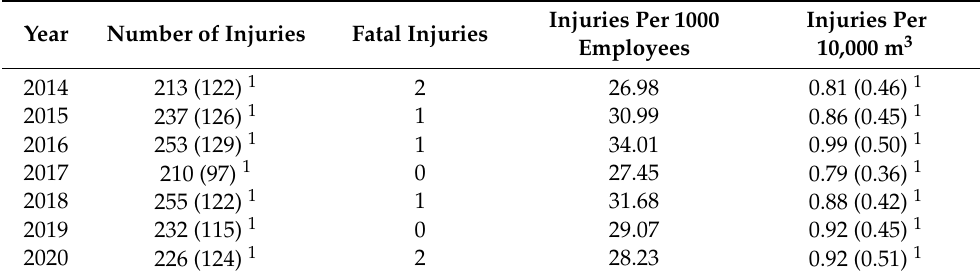
Table 2. Summary of selected safety indicators in the company CF Ltd.